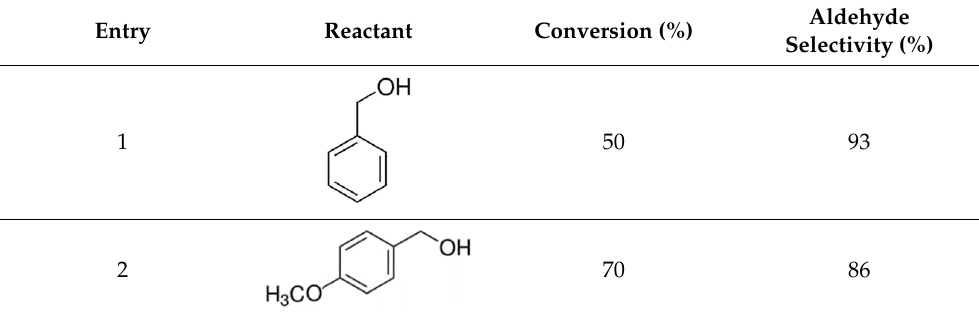
Table 4. Substrates and reaction results of catalytic oxidation of benzyl alcohol (BnOH) derivatives and 4-(benzyloxy)phenol.